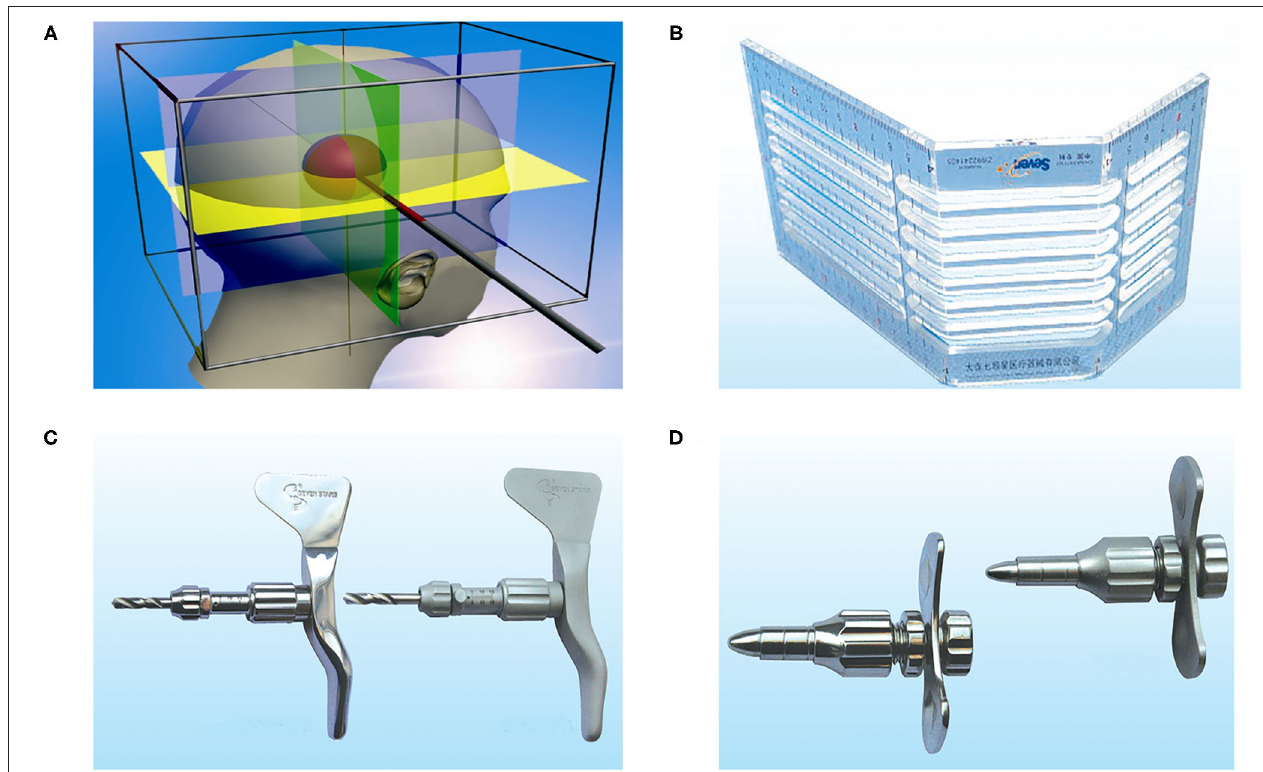
FIGURE 1 | The principle and devices of cubic oriented stereotactic aspiration technology. (A) The principle of cubic oriented stereotactic aspiration: according to the principle of solid geometry, the position of any point in space can be determined by the three-dimensional directional coordinate system. Combining this principle with cranial anatomy, the “quasi-circular” head is “framed” in cube space. According to the principle that three mutually perpendicular planes intersect to form a three line and a point in a cube, a horizontal plane, a coronal plane, and a sagittal plane passing through the point can be made, respectively, to form a three-dimensional directional coordinate system with this point as the origin. According to the parameters of CT scanning, the vertical projection lines and planes in the forehead, temporal part, and top and occipital parts were determined. Then, the center of the hematoma was determined according to the intersection of the three planes. The straight line formed by the intersection of any two planes in the three mutually perpendicular planes can be used as the puncture path and the position of the other plane can determine the puncture depth. This allows accurate access to the center of the hematoma. The stereotactic ruler (B) , skull drill (C) , and skull keyhole tool (D) are used in cubic oriented stereotactic